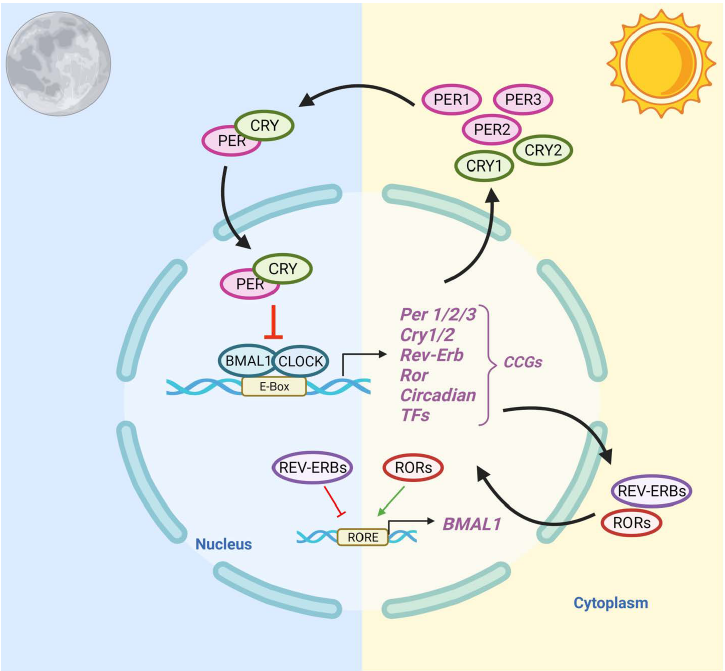
Figure 1. Schematic Representation of the Circadian Clock Transcriptional–Translational Feedback Loops. The main feedback loop is comprised of activator proteins Brain and Muscle ARNT-Like 1 (BMAL1) and Circadian Locomotor Output Cycles Kaput (CLOCK), and two repressor proteins, Period (PER) and Cryptochrome (CRY). BMAL1 and CLOCK heterodimerize and bind to the E-box, which activates the transcription of CRY (1-2), PER (1- 3), RORα, REV - ERBα, and Clock transcription factors (TFs). The primary negative feedback occurs when CRY and PER accumulate and dimerize in the cytoplasm and translocate to the nucleus to inhibit the BMAL1: CLOCK. In the secondary feedback loop, RORα and REV - ERBα activate and inhibit the transcription of BMAL1. While the SCN mainly relies on cues from light–dark cycles to entrain the biological clock, peripheral clocks, such as the ones in the reproductive, endocrine, and immune systems, receive timing signals from the SCN as well as from feeding patterns, tempera- ture, and hormones [48–50]. The feed/fasting cycle dictates nutrient intake within specific periods during the day: the periodic phosphorylation of energy sensors such as AMP- activated protein kinase (AMPK) promotes ATP production in response to exercise/fast- ing and encourages the breakdown of fatty acids, glucose, and triglycerides after eating a meal. AMPK destabilizes CRY1 in peripheral proteins and interacts with SIRTUIN 1(SIRT1), which modulates transcription factors including PER2 [51] . In addition to nutri- ent-sensing molecules, ligand-activated transcription factors can have several effects on